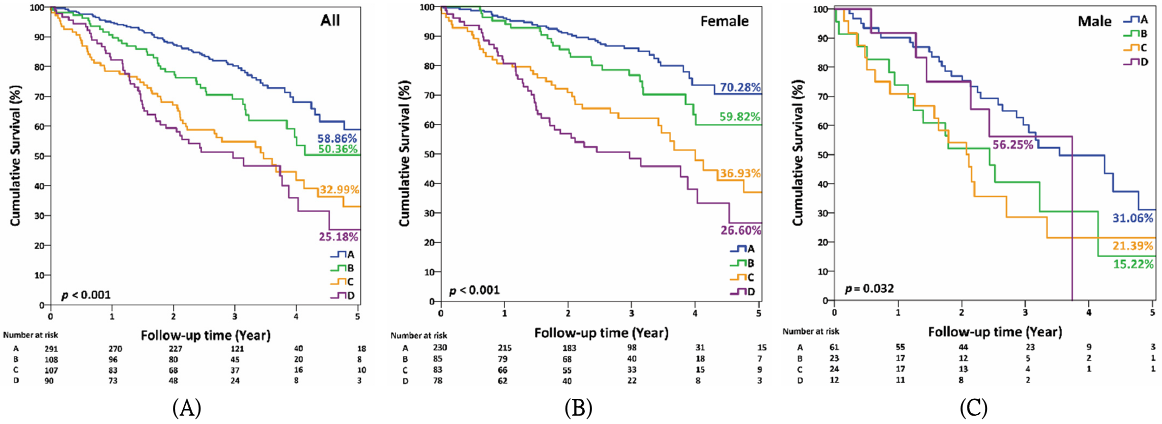
Figure 1. Kaplan–Meier curve of 5-year mortality rates by BMD of spine and right femoral neck in ( A ) all, ( B ) female, and ( C ) male participants. Group A: BMD of lumbar spine ≥ 0.715 g/cm 2 and right femoral neck ≥ 0.550 g/cm 2 . Group B: BMD of lumbar spine < 0.715 g/cm 2 and right femoral neck ≥ 0.550 g/cm 2 . Group C: BMD of lumbar spine ≥ 0.715 g/cm 2 and right femoral neck < 0.550 g/cm 2 . Group D: BMD of lumbar spine < 0.715 g/cm 2 and right femoral neck < 0.550 g/cm 2 . Comparisons of survival curves by log-rank test. Figure ( A ): all pairwise p < 0.05 except C vs. D; Figure ( B ): all pairwise p < 0.05 except A vs. B and C vs. D; Figure ( C ): A vs. B and A vs. C, p <